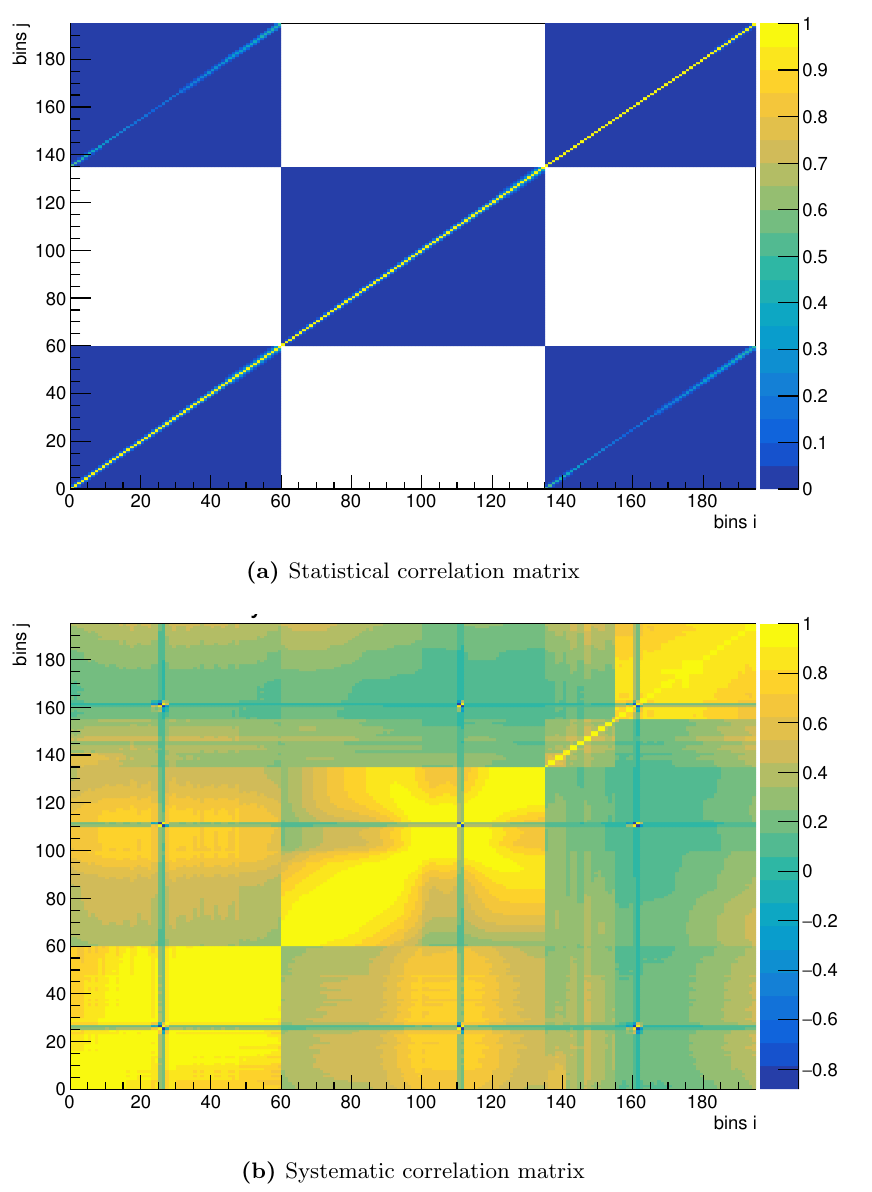
Figure 3. The correlation structure of the 195x195 statistical and systematic combination matrices. In each case, the axis on the right represents the overall correlation coe(cid:14)cient ( (cid:26) ij = (cid:0) 1 (cid:20) (cid:26) (cid:20) 1), where the corresponding colour indicates the degree of correlation at each point in the respective matrix (colour